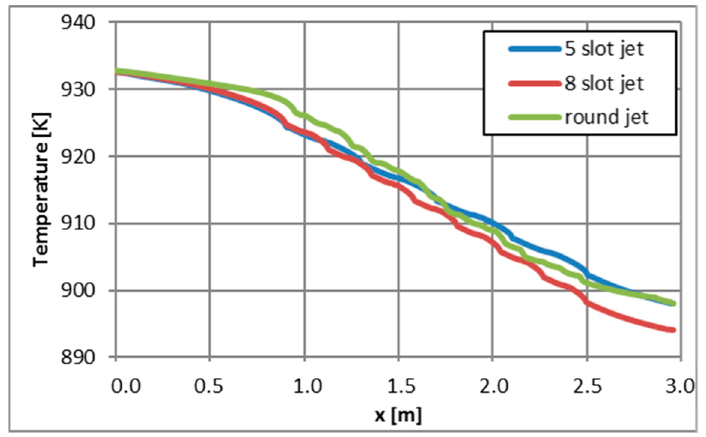
Figure 23. Temperature contours on the tape surface along its movement direction. Table 9. Main thermal parameters obtained in the different configurations.